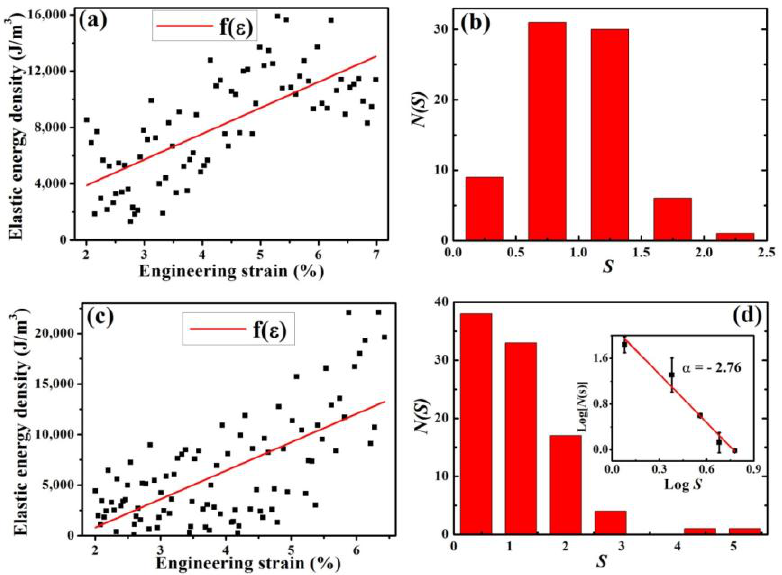
Figure 3. ( a ), ( c ) The profiles of elastic energy density vs. strain. The red lines are baselines, f (ε), by linearly regression fitting at the strain rates of 2 × 10 −3 , and 2 × 10 −4 ·s −1 . ( b ), ( d ) The statistical distributions of elastic energy densities, N ( s ) at the strain rates of 2 × 10 −3 , and 2 × 10 −4 ·s −1 , respectively. Inset shows a power-law distribution of the elastic energy density at the strain rate of 2 × 10 −4 ·s −1